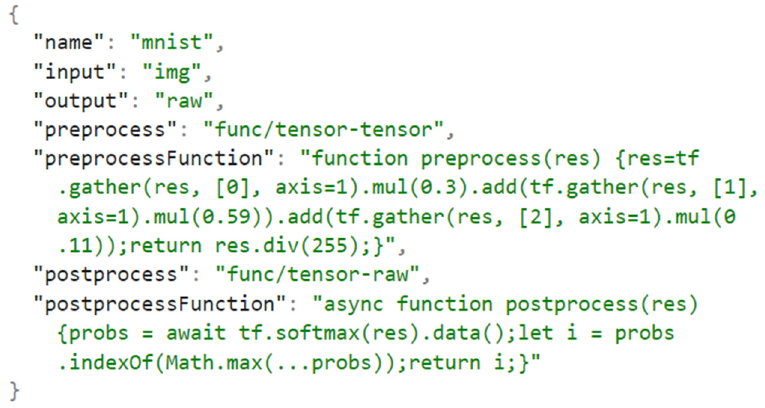
Figure 2. A sample configuration file.